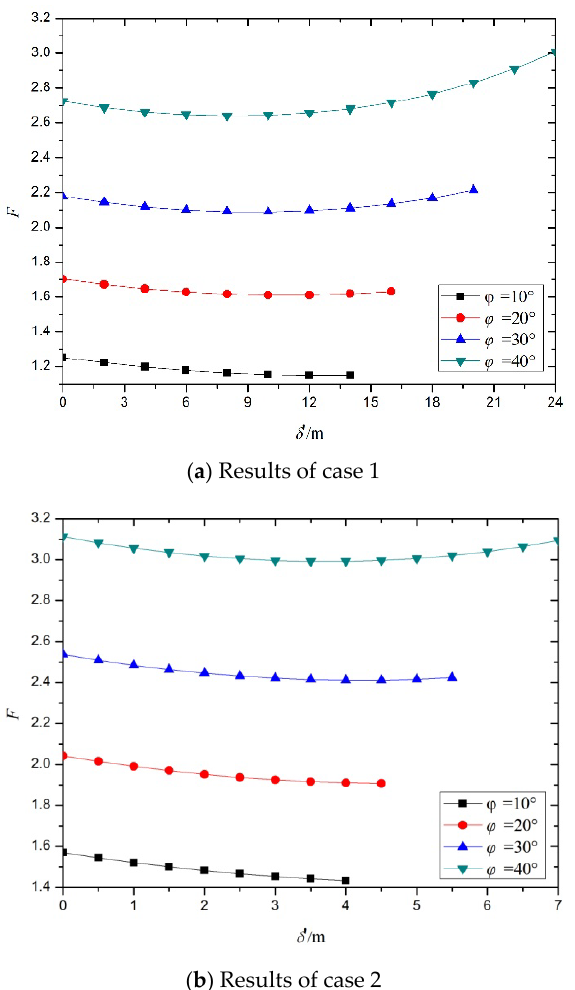
Figure 11. Relationship between safety factor and crack depth under different friction angle of soil.